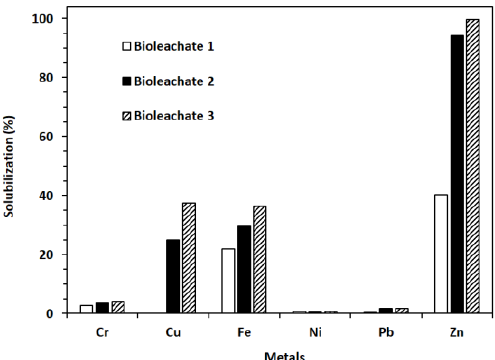
Figure 3. Metals’ solubilization from the gold concentrate during the biooxidation process using new ( Bioleachate 1) and reuse effluents ( Bioleachate 2 and Bioleachate 3) as a culture medium.